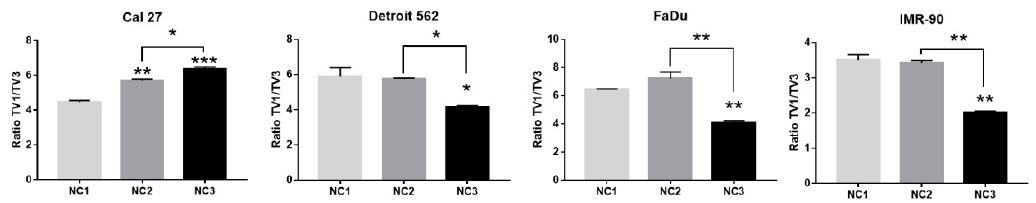
Figure 6. The dependence of the TV1 / TV3 ratio on NCs applied. One-way ANOVA with Tukey post-hoc test. The ascending trends were recorded in Cal 27 as contrasted with the other three cell lines. The values are shown as the mean ± SD. N = 3. * p < 0.05; ** p < 0.01; *** p < 0.001; **** p < 0.0001.